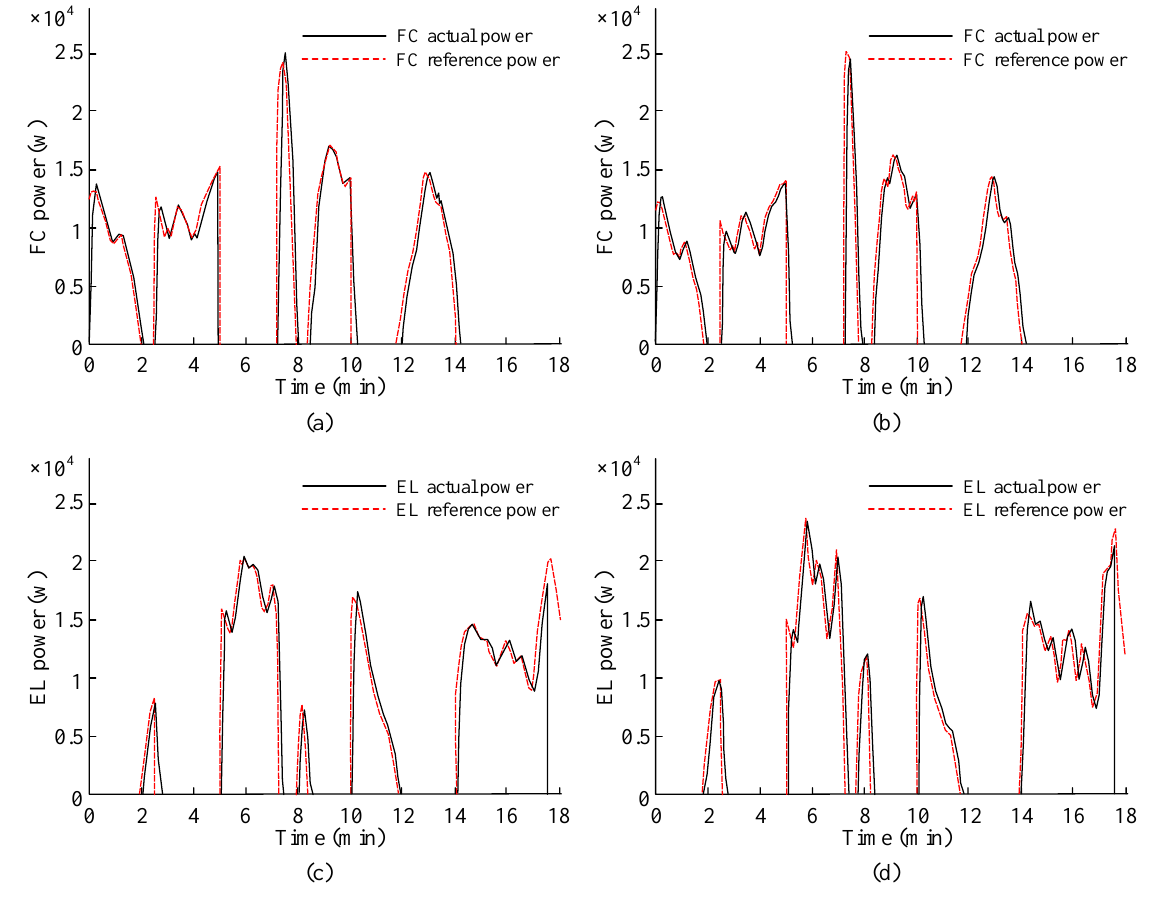
Figure 9. FC and EL power change curve.